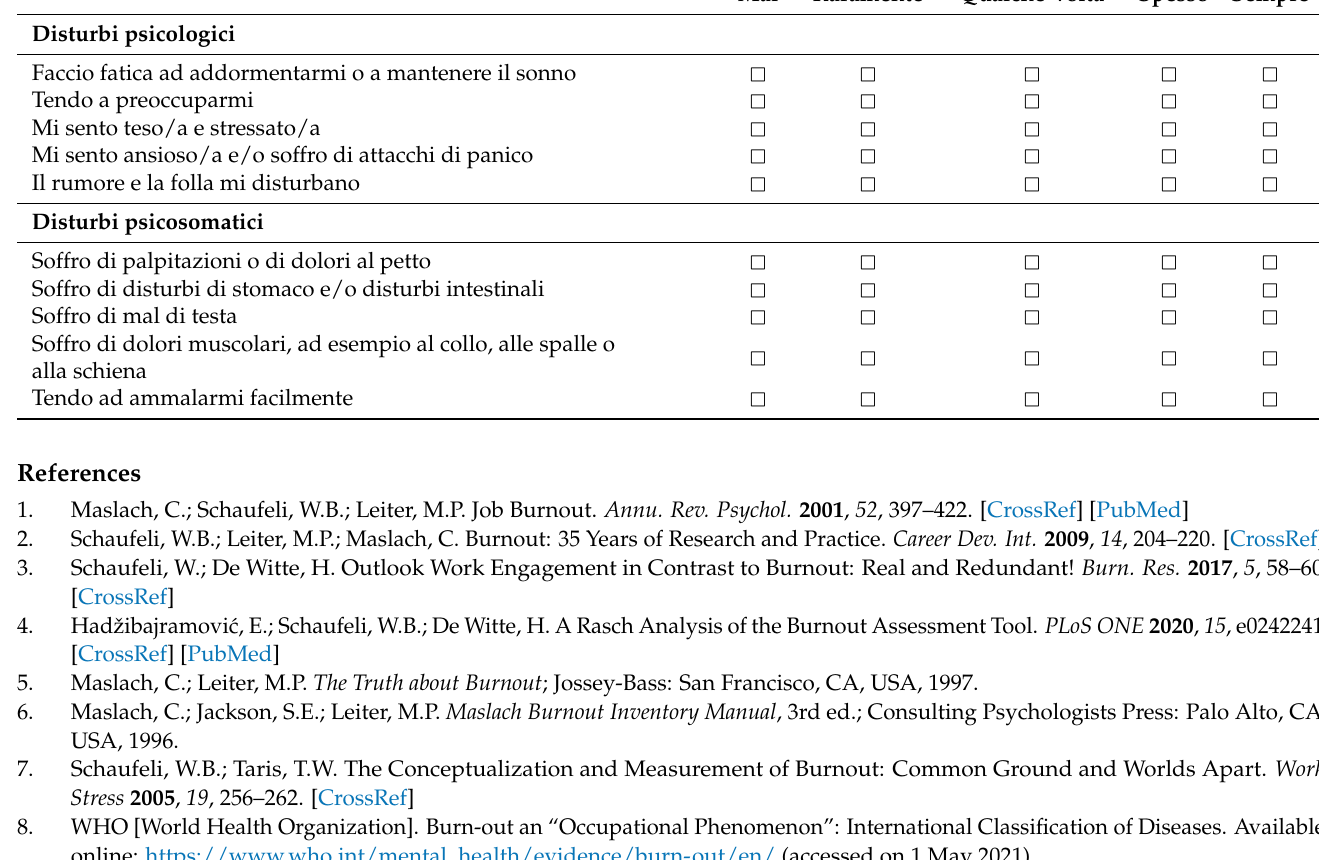
Table A2. Italian version of the Burnout Assessment Tool (BAT)-Secondary symptoms.